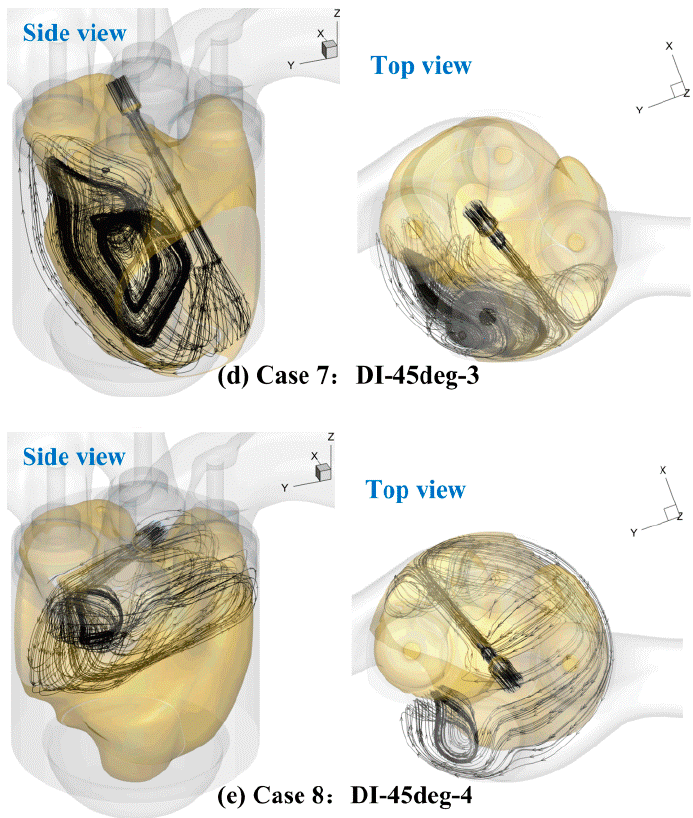
Figure 7. The in-cylinder TKE iso-surfaces (50 (m 2 /s 2 )/kg) and jet streamlines of Cases 5–8 at CA610.